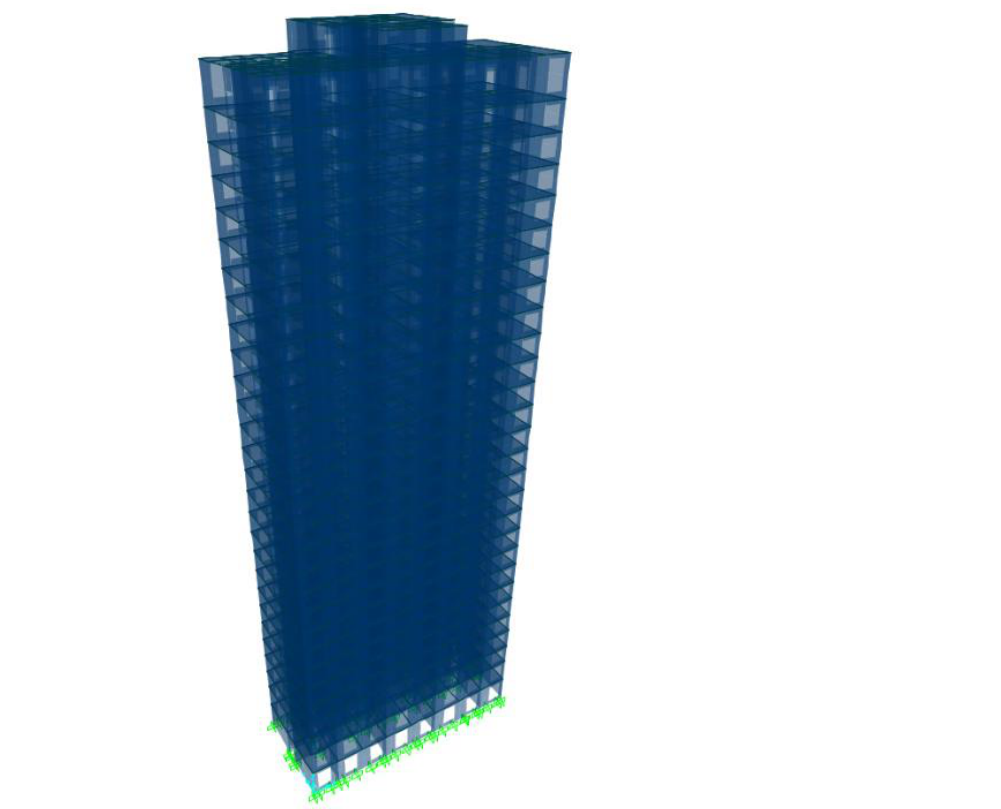
Table 2. The first three-order frequencies of the test and numerical results (Unit: